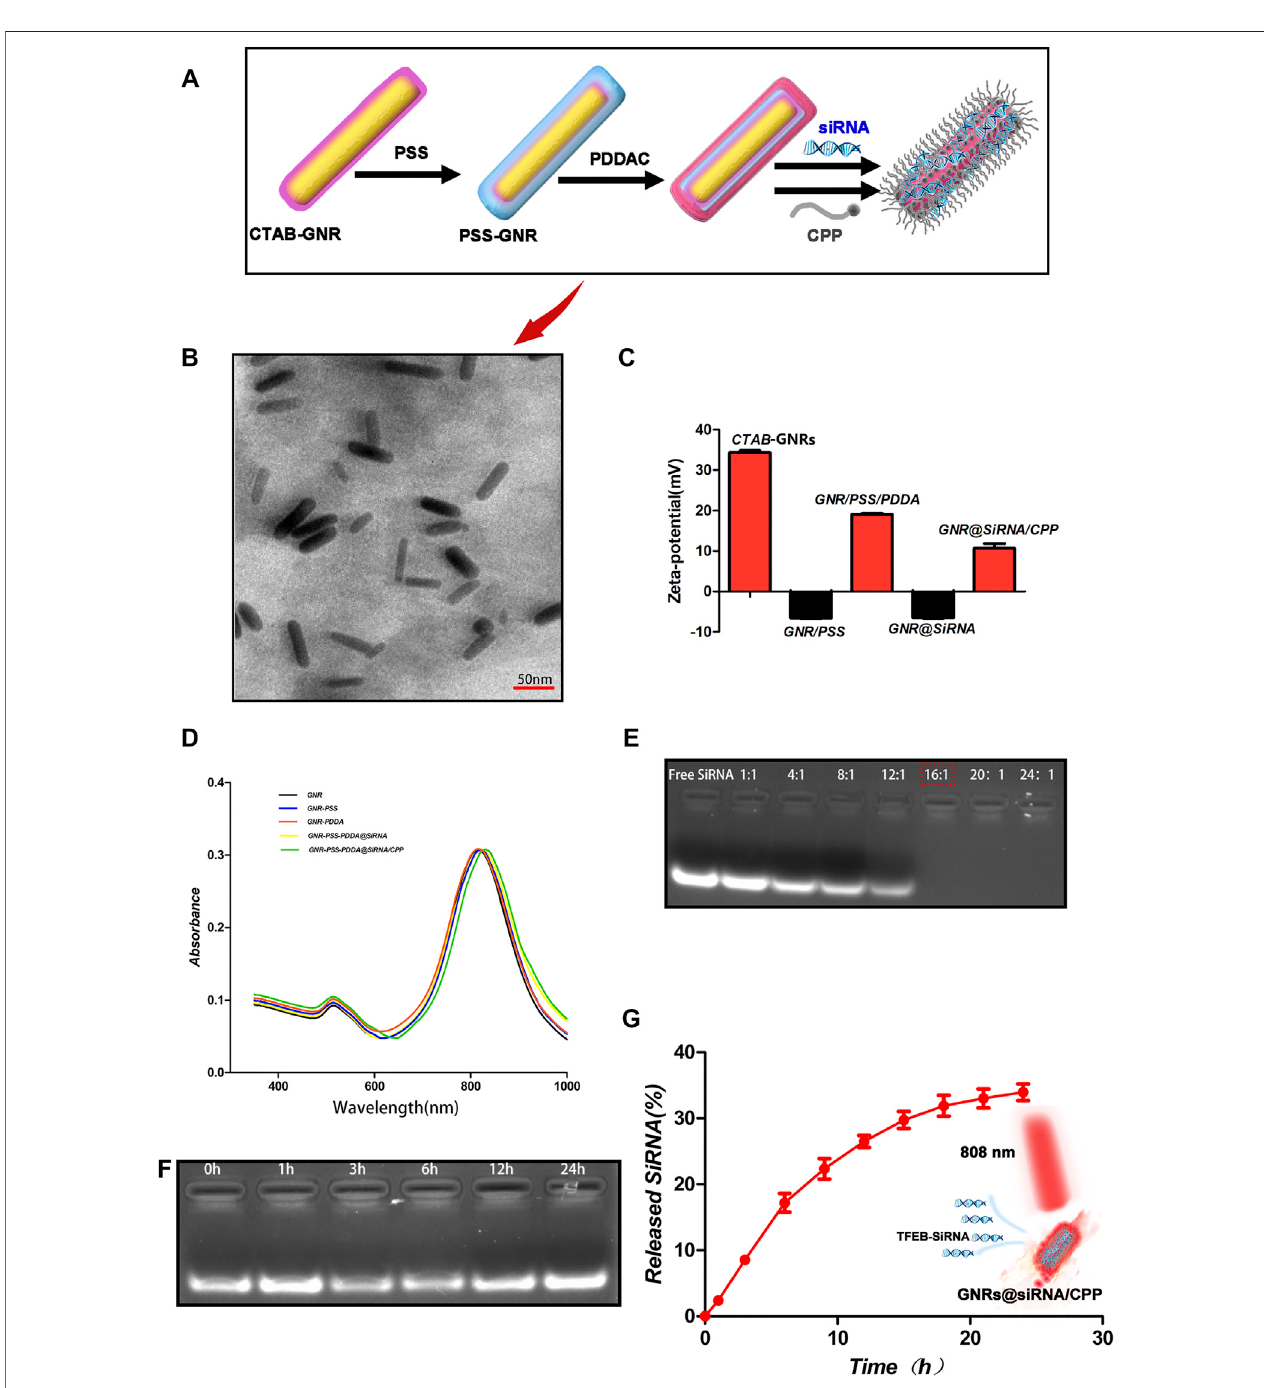
FIGURE 1 | Characterization of the nanoplatforms. (A) Schematic illustration of the synthesis of GNR@siRNA/CPP nanorods. (B) TEM images of GNR@siRNA/ CPP nanorods. (C, D) Zeta potential and UV-vis spectrum of GNRs, GNR-PSS, GNR-PSS-PDDAC, GNRs-PSS-PDDAC-siRNA (GNRs@siRNA), and GNR/PSS/ PDDAC-siRNA-CPP (GNR@siRNA/CPP). (E, F) Agarose gel retardation assay of GNR/siRNA complexes under various weight ratios and protection of siRNA against fetal bovine serum digestion. (G) siRNA cumulative release from GNR@siRNA/CPP complexes at different points in time.